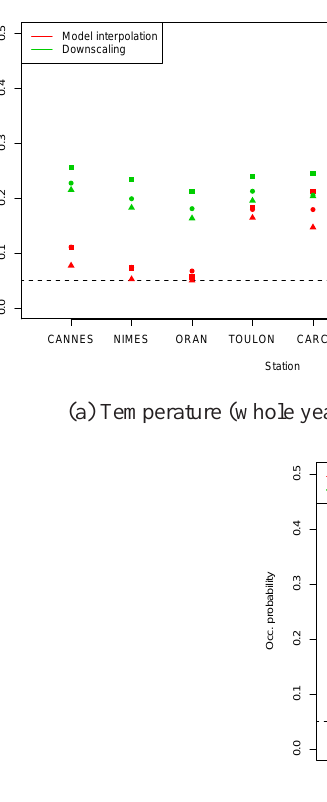
(b) Temperature, 2081-2100 Fig. 6: Circle areas are proportional to the KS scores computed over the whole year (i.e., no seasonal discrimination) between the CDFs of temperature from each GCM during the validation period and those during the two future periods (2046-2065 on the left and 2081-2100 on the right) under the A2 scenario. Crosses indicate the location of each station. The CDFs are computed using either the interpolation (right side with respect to the cross) or the downscaling method (left side with respect to the cross). Black and grey circles display the 80% and 90% confidence levels (i.e., α = 0 . 2 and 0 . 1 ) of the KS scores.